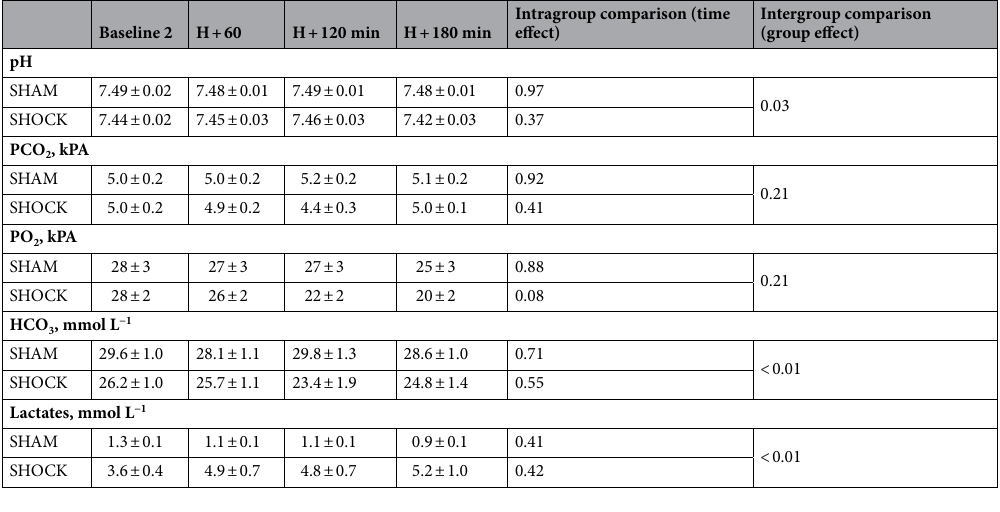
Table 3. Biological parameters during three consecutive hours from baseline 2 (Cardiogenic Shock). Data from n = 8 SHAM and n = 17 SHOCK independent experiments, expressed as mean ± SE. Two-way ANOVA was performed for comparison of multiple means.